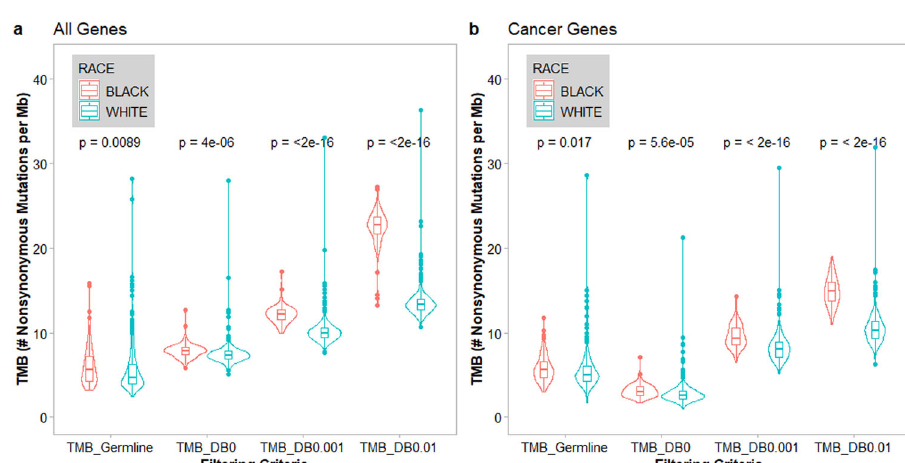
Fig. 1 Impact of variant fi ltering criteria on TMB calculation. The TMB values were calculated as number of nonsynonymous mutations per Mb of coding regions. Four criteria were applied to identify patient-speci fi c somatic mutations: (1) TMB_Germline: excluding variants in patient-matched germline exome; (2) TMB_DB0: excluding all variants reported by 1000G or ExAC; (3) TMB_DB0.001: excluding variants with MAF ≥ 0.1% in 1000G or ExAC; and (4) TMB_DB0.01: excluding variants with minor allele frequency (MAF) ≥ 1% in 1000G or ExAC DBs. The violin and box plots in red are TMB values from Black patients, and blue are from White Patients. a Comparisons of TMBs calculated from all protein-coding genes in Black and White patients from four variant fi ltering criteria. b Comparisons of TMB calculated from 1059 cancer genes in Black and White patients from four variant fi ltering